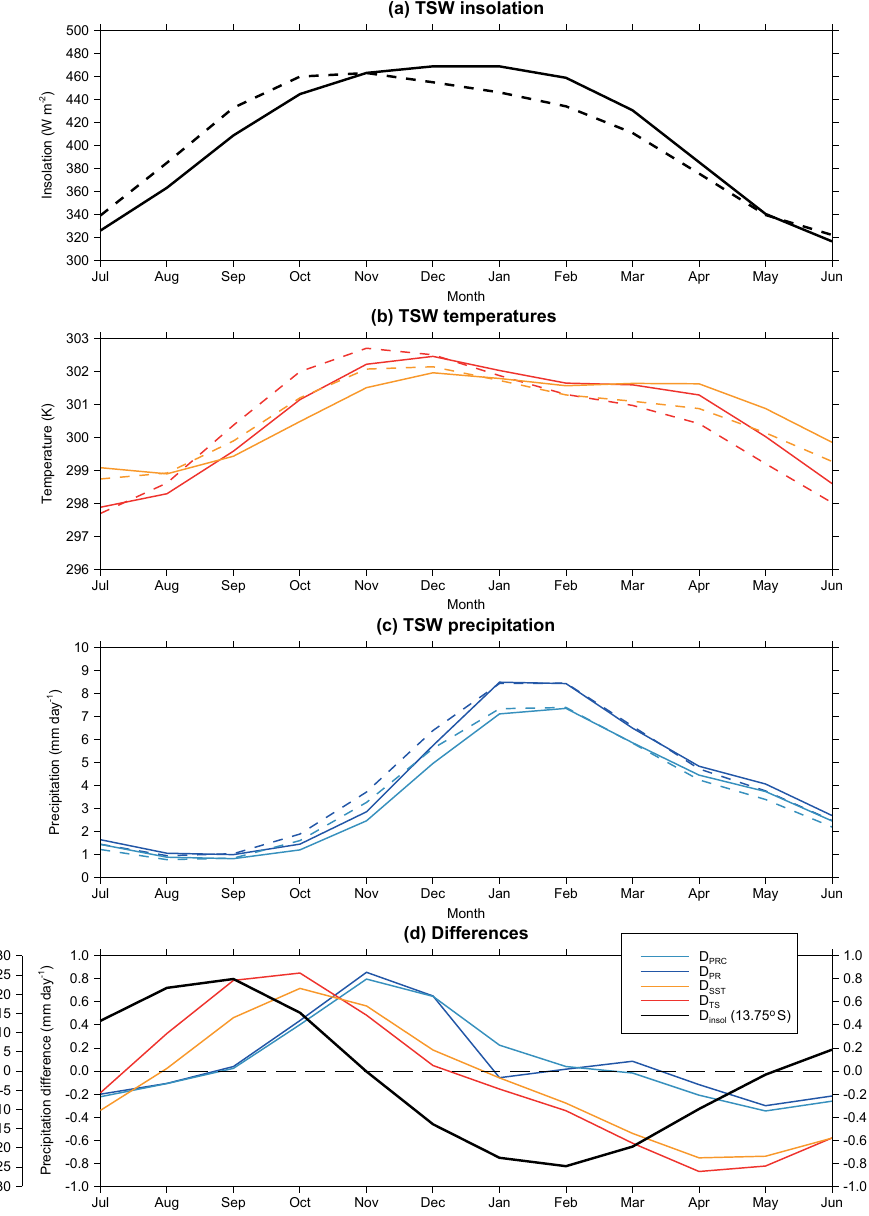
Figure 7. The monthly, ensemble and regional mean (a) insolation (taken at 13.75 ◦ S for insolation, black line, Wm − 2 ), (b) surface tem- perature (land and ocean combined, red line, K) and sea surface temperature (when available, amber line, K) and (c) total precipitation (blue line, mmday − 1 ) and convective precipitation (turquoise line, mmday − 1 ) at 0ka (solid lines) and 6ka (dashed lines) within the TSW box. The difference in those fields (insolation, temperature and precipitation) for 6 − 0ka is plotted in (d)